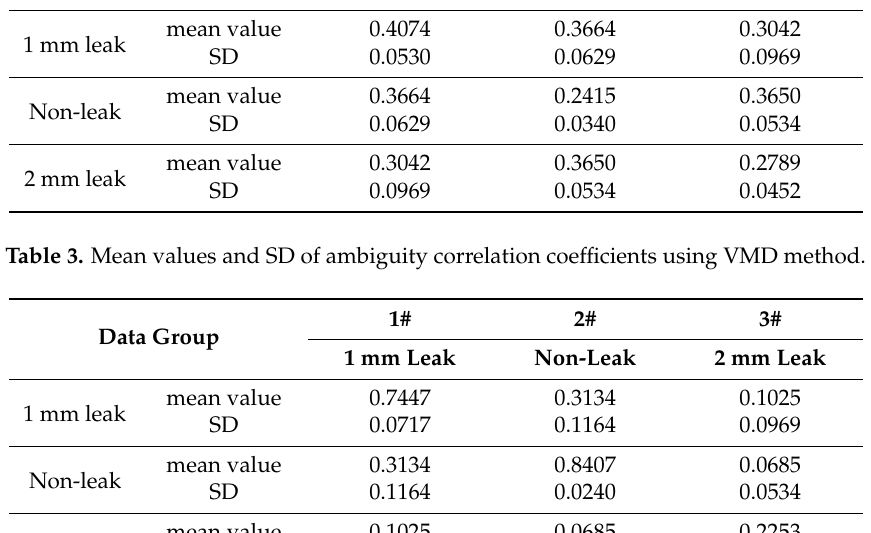
Table 2. Mean values and SD of ambiguity correlation coefficients using EMD method.